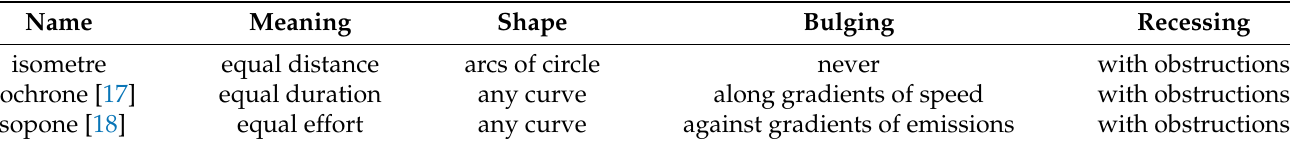
Table 2. Types of isolines considered in this